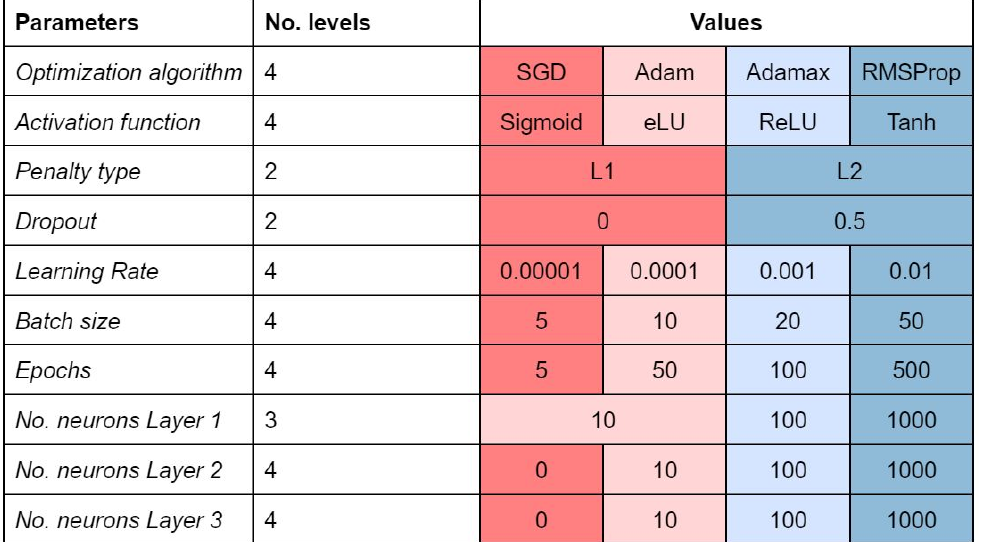
Figure 5. Hyperparameters to be tuned and the levels considered. Levels are colored to facilitate the comprehension of Figure 4.